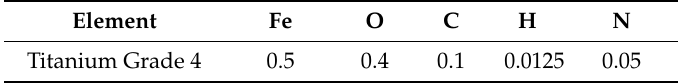
Table 1. Chemical composition of the experimental material (weight %).